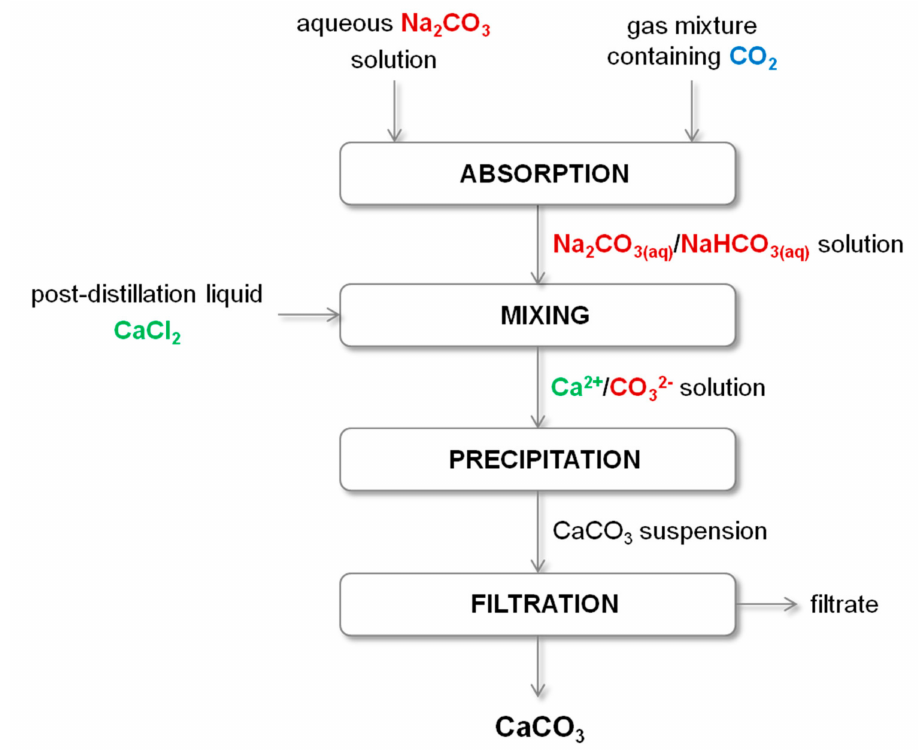
Figure 2. Diagram of the CaCO 3 precipitation process using post-distillation liquid from the Solvay process and aqueous Na 2 CO 3 solution saturated with CO 2 .